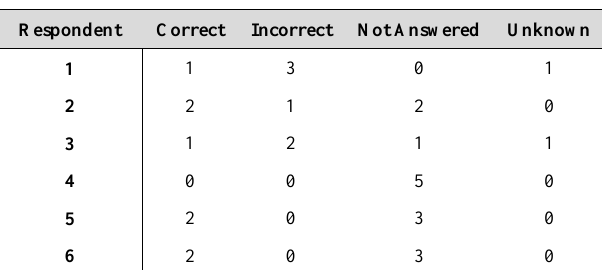
Table 5. Overall RMSE of data entry in task